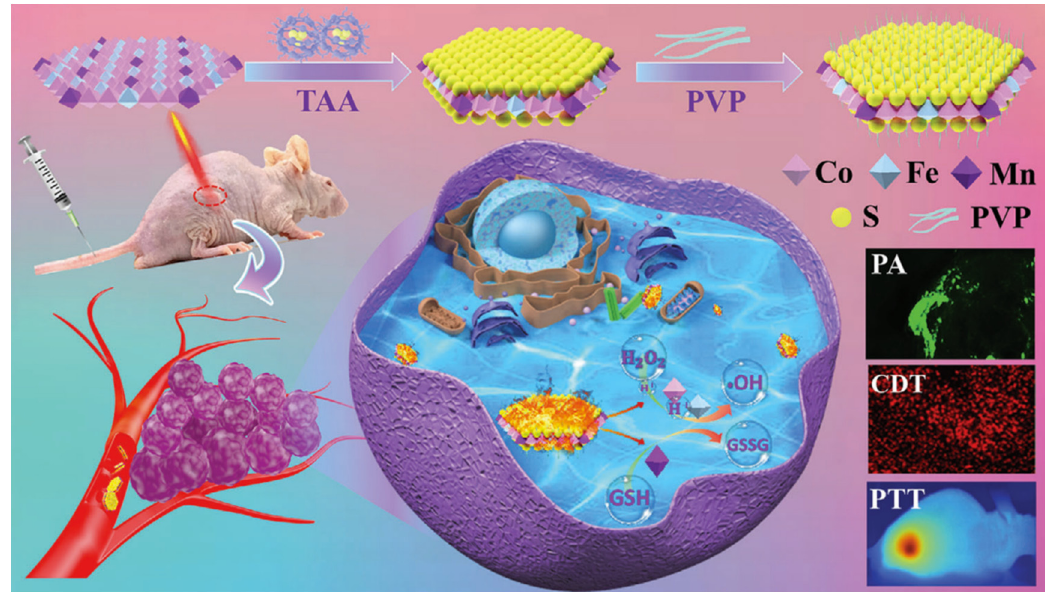
Figure 1. A schematic illustration for preparing CoFeMn dichalcogenide nanosheets to give efficient photothermal therapy and photoacoustic imaging [12] .